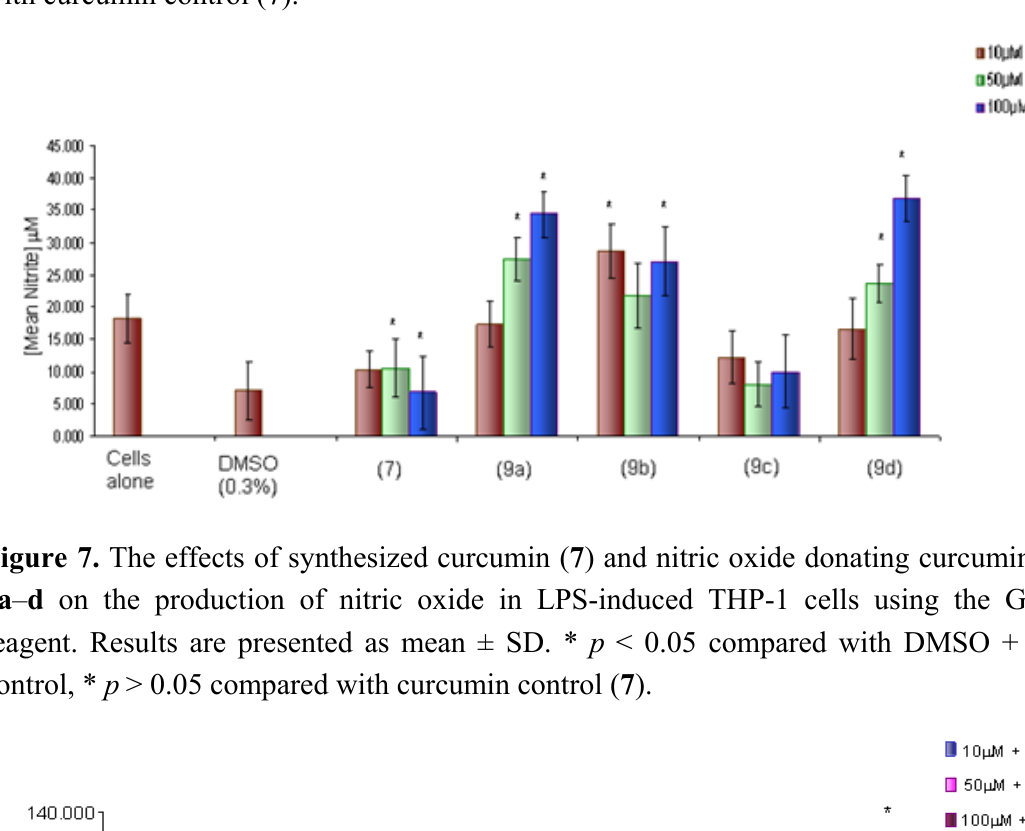
Figure 6. The effects of synthesized curcumin ( 7 ) and nitric oxide donating curcuminoids 9a – d on the production of nitric oxide in THP-1 cells using the Griess reagent. Results are presented as mean ± SD. * p < 0.05 compared with DMSO control, * p > 0.05 compared with curcumin control ( 7 ).